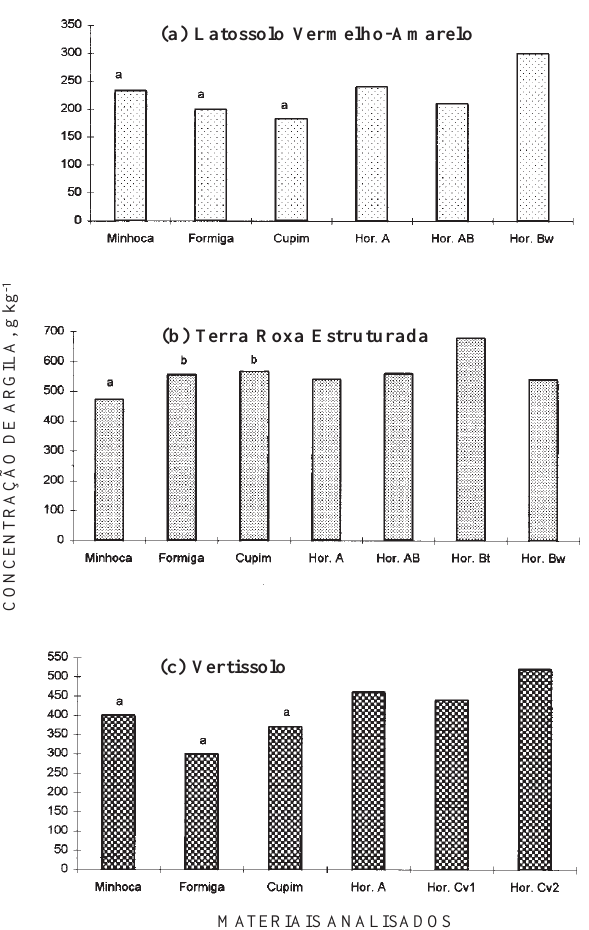
Figura 3. Concentração de argila nos agregados biológicos e no solo-controle. (Os teores de argila das estruturas biogênicas seguidos da mesma letra não diferiram pelo teste de Tukey a